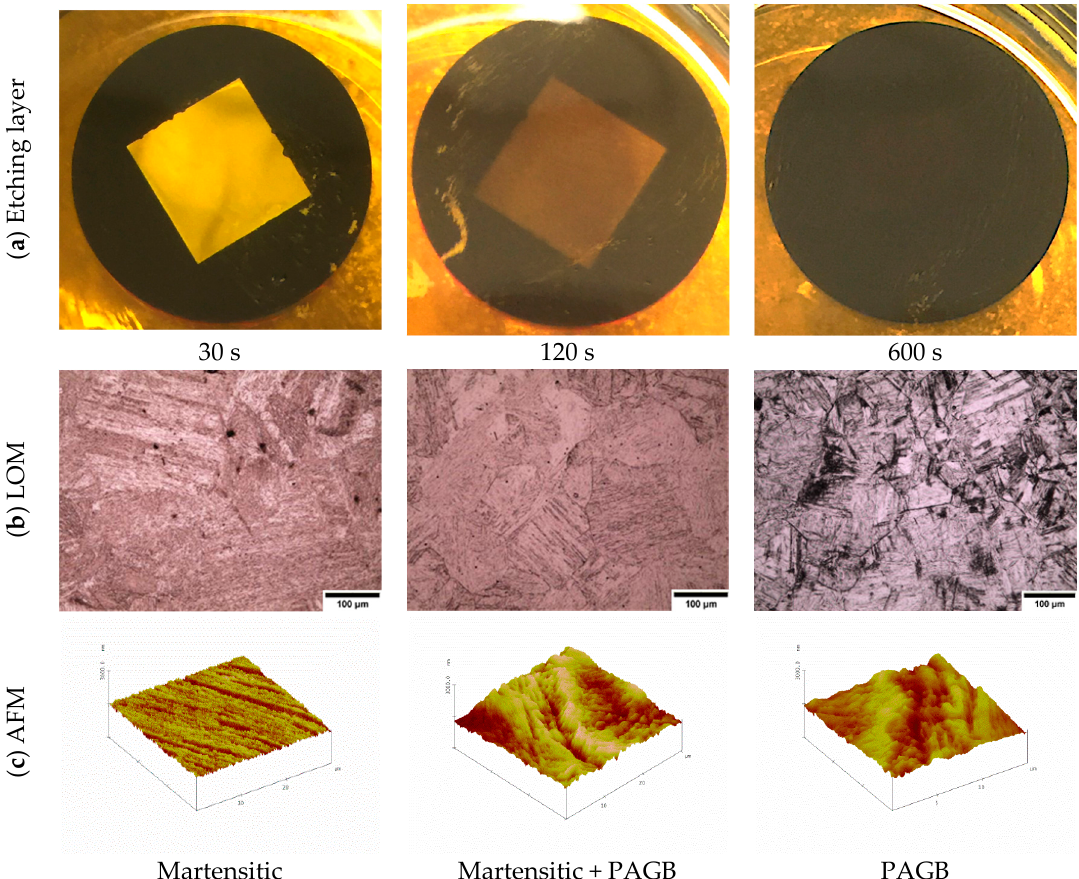
Figure 5. The effect of submerging the specimen for different time durations in saturated picric acid with sodium dodecyl sulfate added. Samples shown here are 0.8 wt.% carbon with 0.005wt.% niobium. ( a ) shows the etching layer on the specimen surface getting thicker with increased time, ( b ) shows the effect of time on the etched microstructure and ( c ) shows the topography of the specimen surface at each time duration.